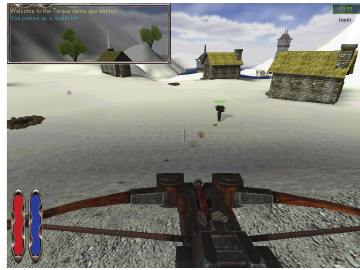
Figure 5: First-person shooter game [24].